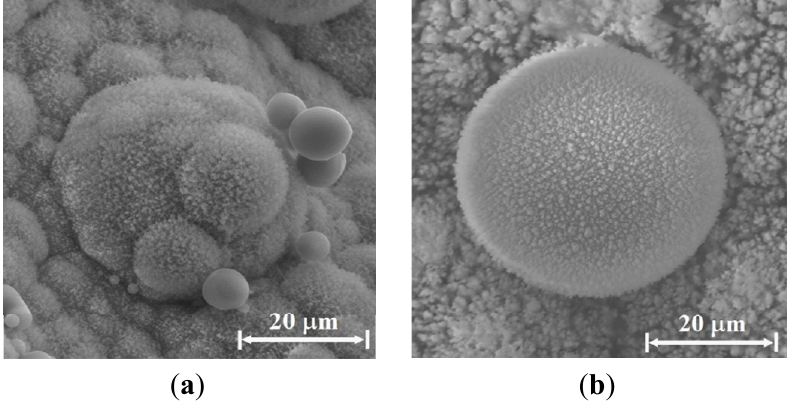
Figure 12. Examples of hairy sea-urchin-like clusters observed by SEM on the copper collector, as ( a ) was created by a Si-emitter, C-electrode, and Cu-collector system, in water-vapor sprayed air atmosphere; and ( b ) was obtained in the same conditions with sodium bicarbonate added to the water vapor